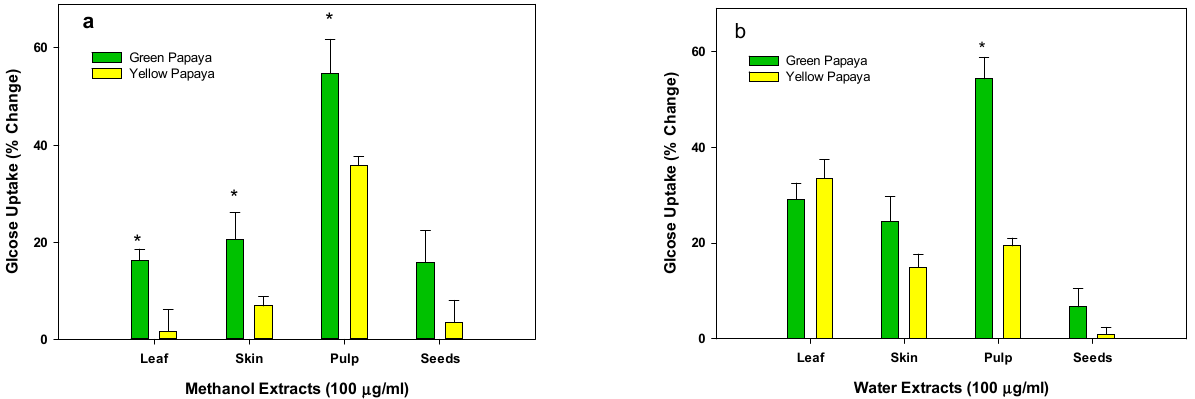
Figure 4. Glucose uptake by green and yellow papaya extract: The glucose uptake stimulatory activity in HepG2 liver cells was conducted using a 2-NBD-glucose, a cell-permeable glucose analog (Cayman Chemical Glucose Uptake Cell-Based Assay Kit) as described in the text. The experiment was conducted in triplicate and data were expressed as % change from vehicle-treated control cells. The statistical analysis was performed using Student’s t test between green and yellow papaya. The significant difference is represented by “*” at p < 0.05.